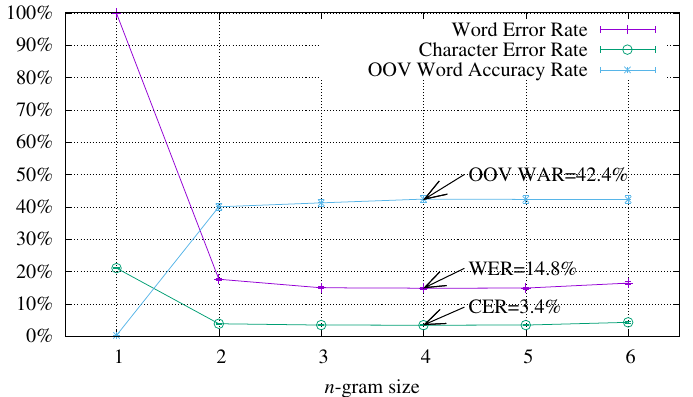
Figure 18. Results obtained by the CRNN sub-word-based system using n -gram language models with size n = { 1, . . . ,6 }